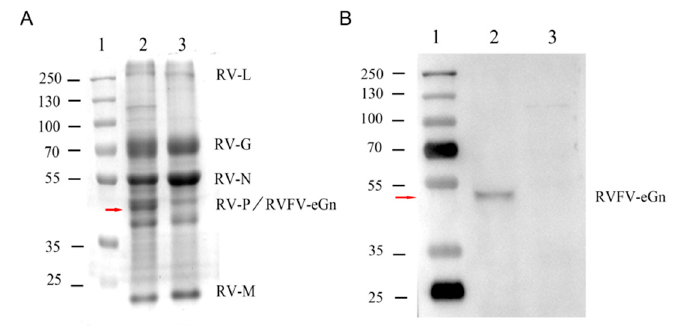
Figure 4. SDS-PAGE and Western blot analysis of virions harvested by sucrose gradient purification. ( A ) The positions of the RABV N, P, M, G, and L proteins were determined by SDS-PAGE. ( B ) Western blot analysis of purified virions probed with a monoclonal antibody against RVFV eGn. In the two images, lane 1 is the molecular mass standards, lane 2 is the rSRV9-eGn, and lane 3 is the rSRV9.